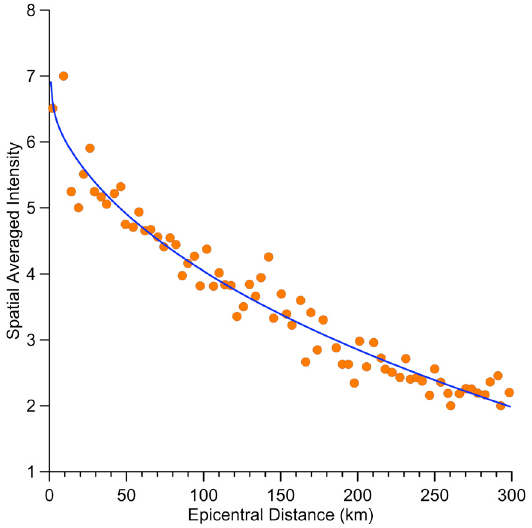
Figure 2. Macroseismic attenuation as a function of epi- central distance. The orange dots are the spatial averaged intensities within intervals of epicentral distance of 4 km of width, the blue line represents the polynomial fit (Eq.